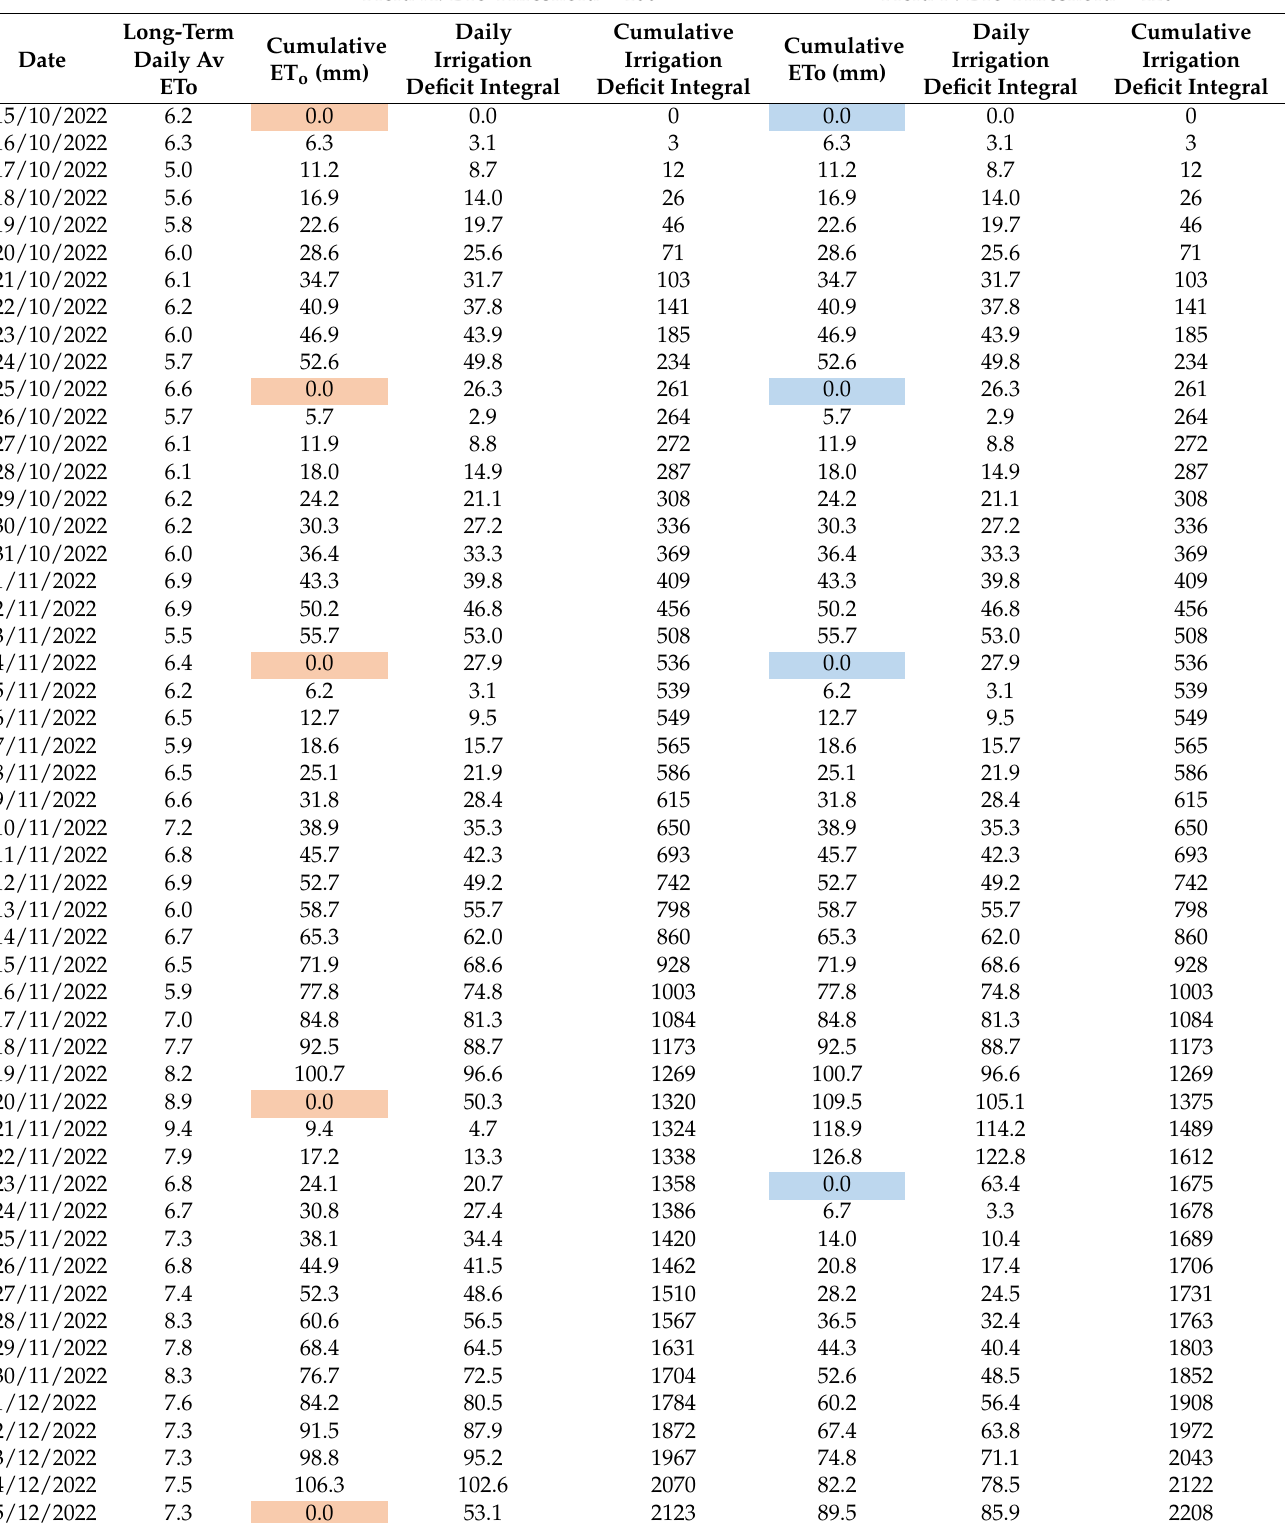
Table 2. Demonstration of the model used as a decision support to test whether PI is predicted to occur before the desired date based on input parameters from Table 2. The colored background is used to highlight when an irrigation event was scheduled as a result of surpassing the respective ETo